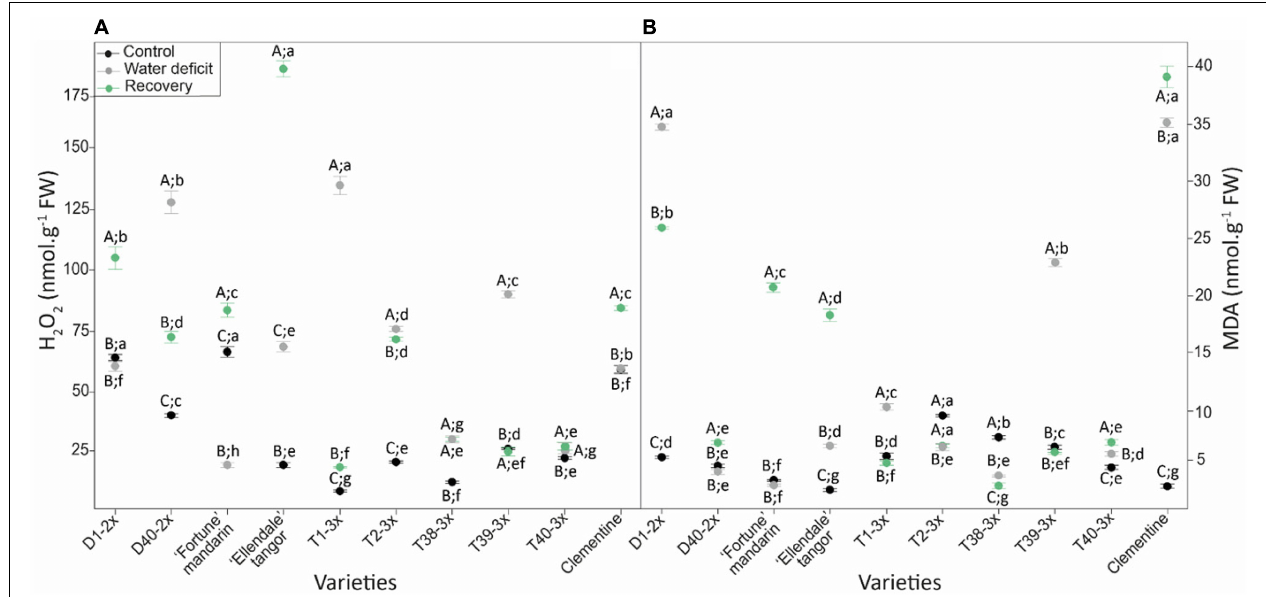
FIGURE 4 | Evolution of (A) hydrogen peroxide (H 2 O 2 ) and (B) malondialdehyde (MDA) contents in leaves of varieties under three different water conditions: control (black points), water deficit (gray points), and after rehydration (recovery; green points). All data are mean values ( ± S.E.) of three independent measurements ( n = 3). Data were analyzed using ANOVA and Fisher LSD test ( P < 0.05). Different capital letters indicate significant changes between the conditions (control, water deficit, and recovery) for each variety while different lower case letters indicate changes between the varieties for each